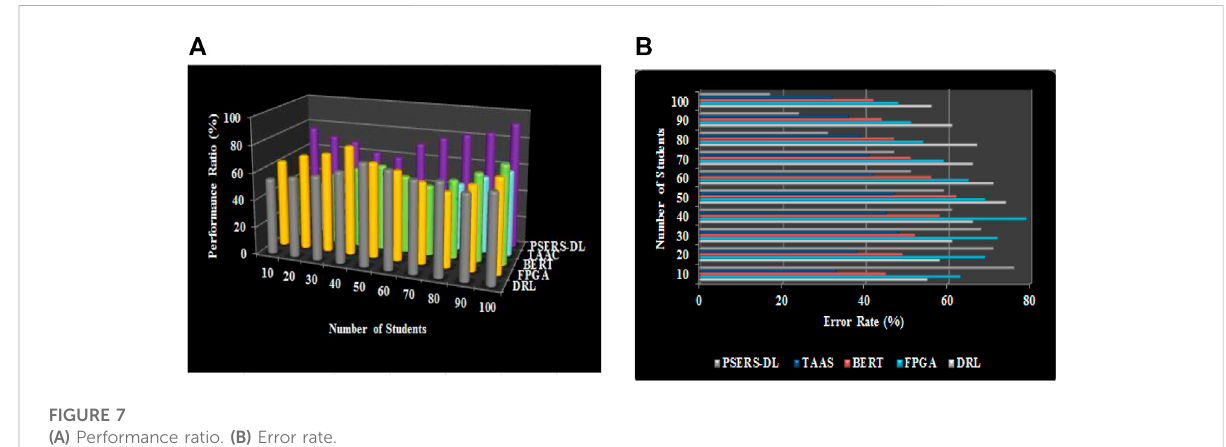
FIGURE 7 (A) Performance ratio. (B) Error